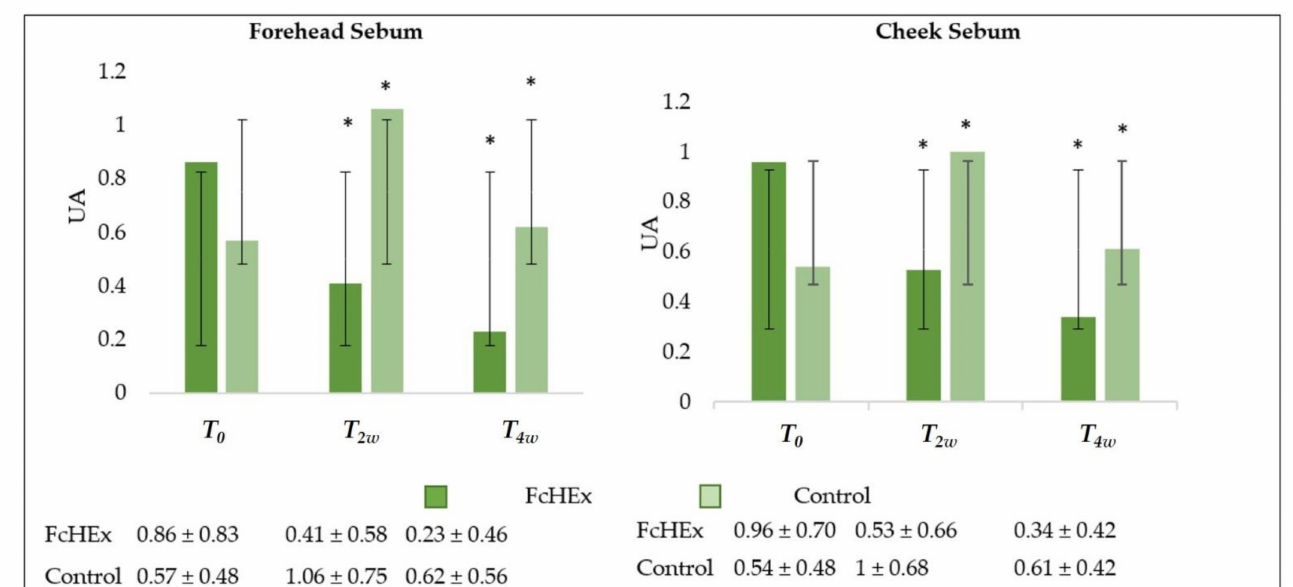
Figure 10. Sebum production evaluation on the forehead and cheek of volunteers. The sebum production trend values at time T 0 (before the application), T 2w (after two weeks—acute stress), T 4w (after four weeks—recovery effect). All the measurements for T 2w vs. T 0 and T 4w vs. T 0 for the FcHEx and the control were statistically significant. The asterisks indicate statistically significant values (* p -value was between 0.01 and 0.05).